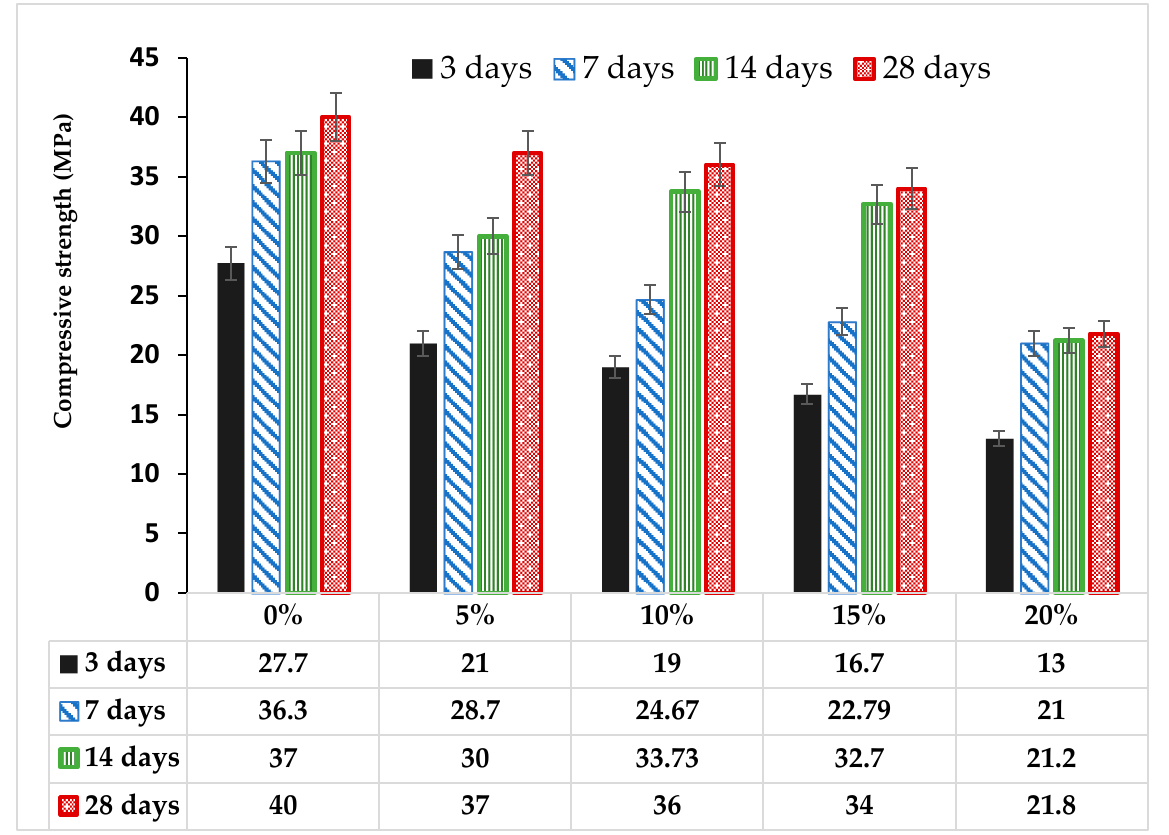
Figure 8. Variation of strength with glass powder in mortar.